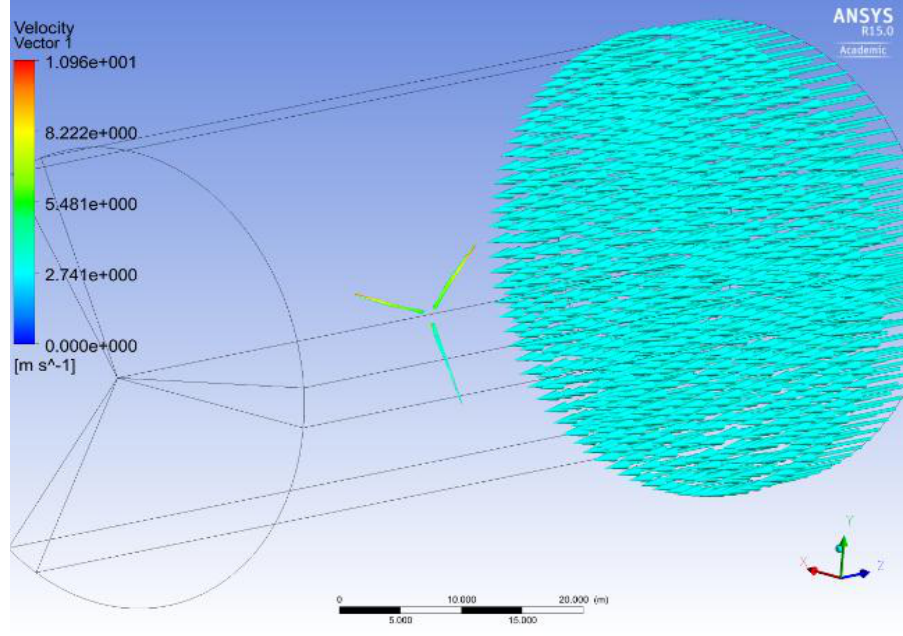
Figure 4. The numerical model of the three-bladed rotor in a cylindrical fluid domain.